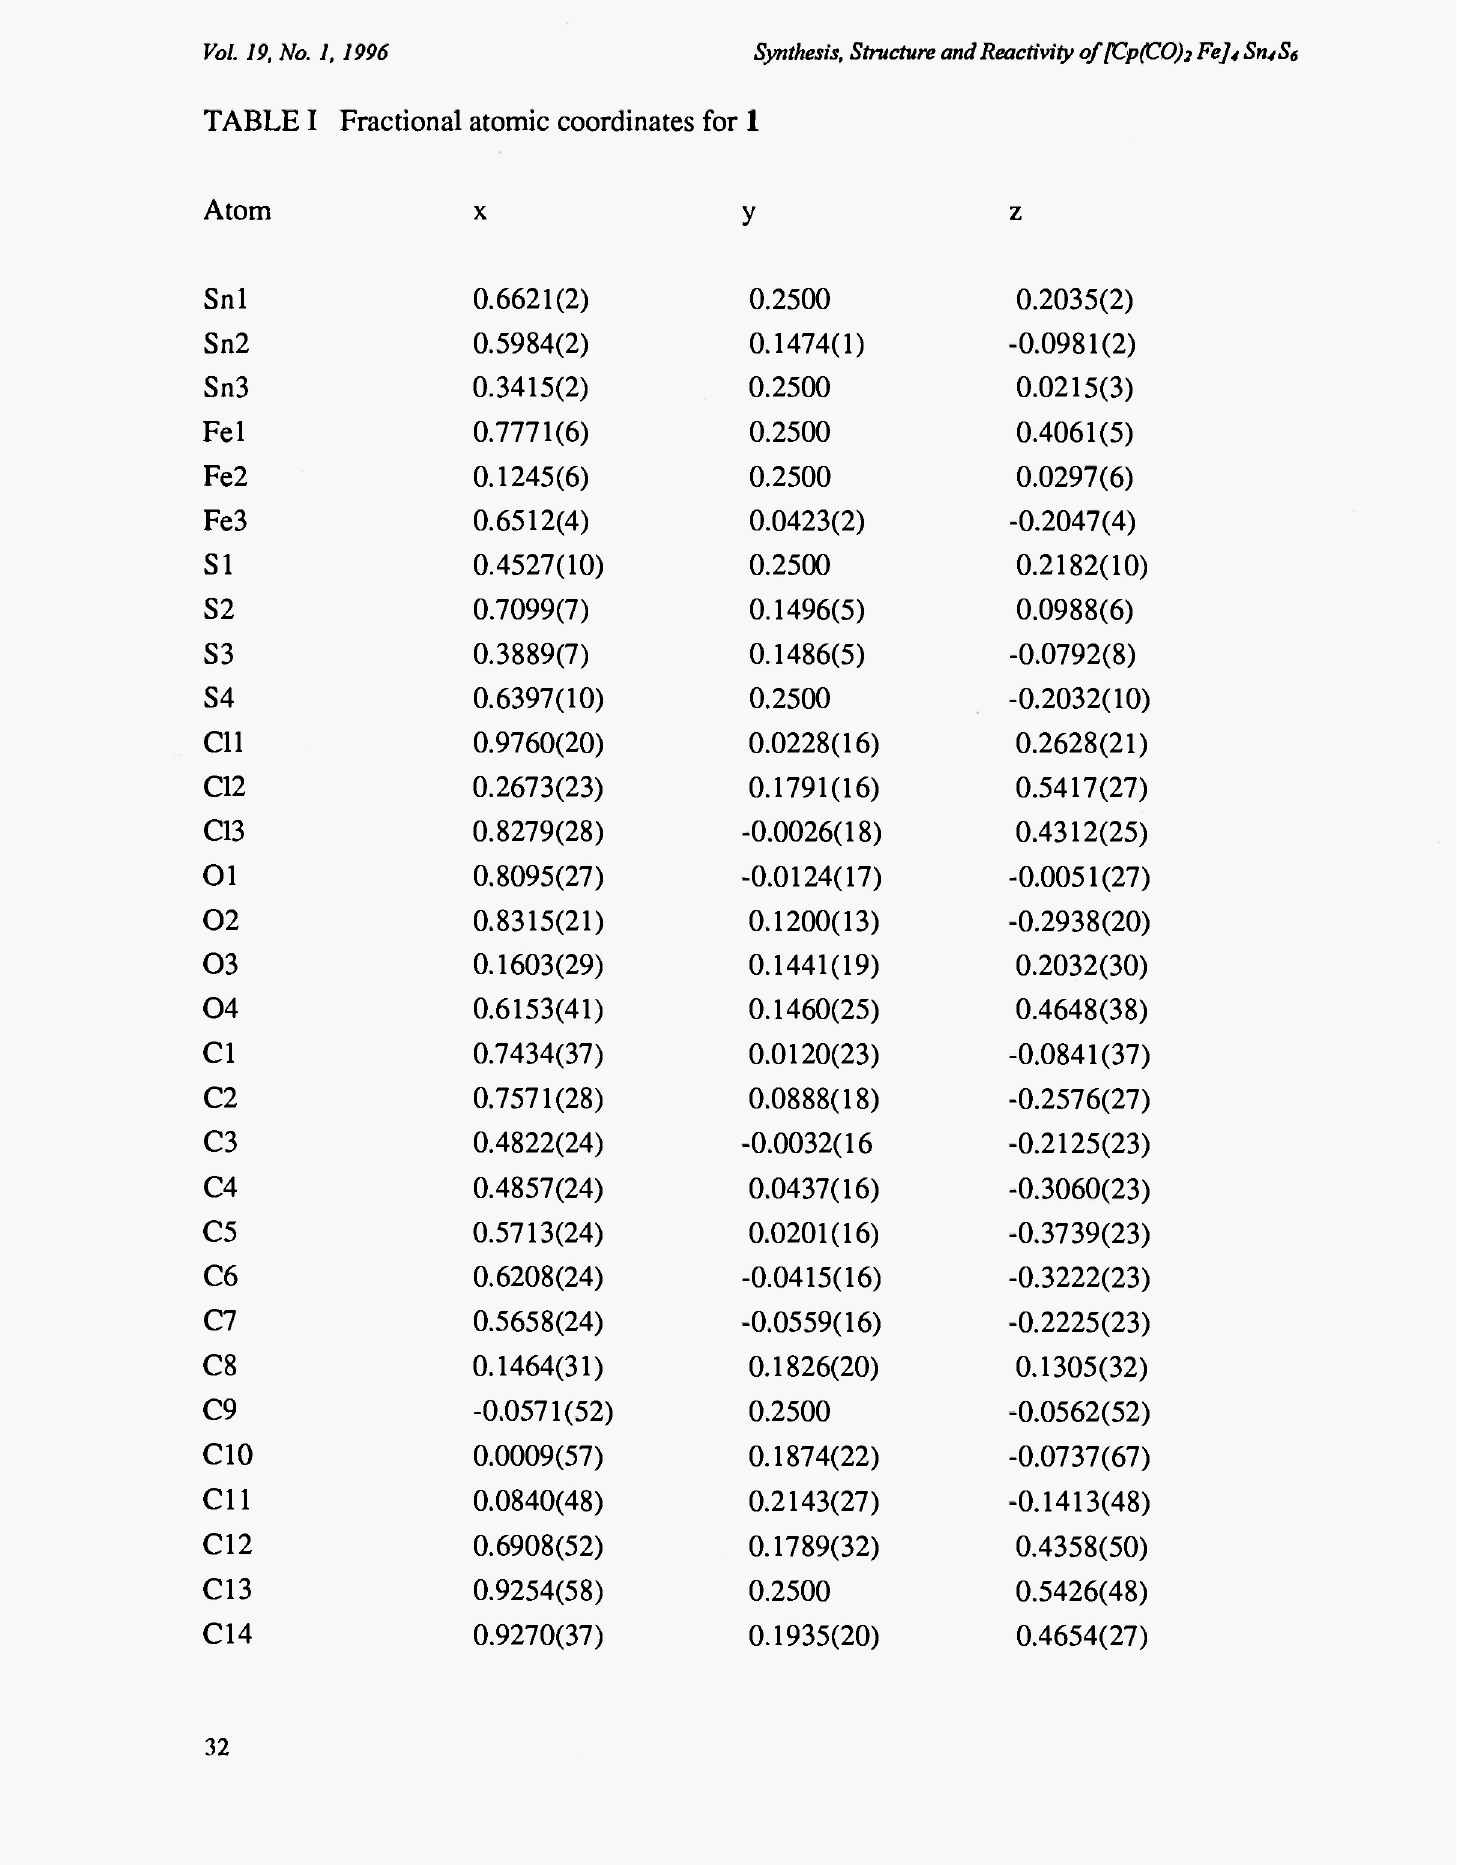
TABLE I Fractional atomic coordinates for